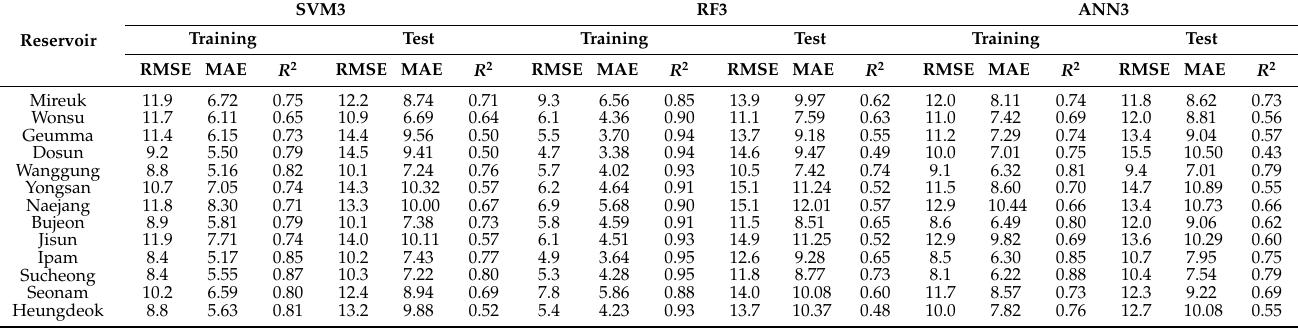
Table 9. Performance of applied models in the training and test phases for three-month